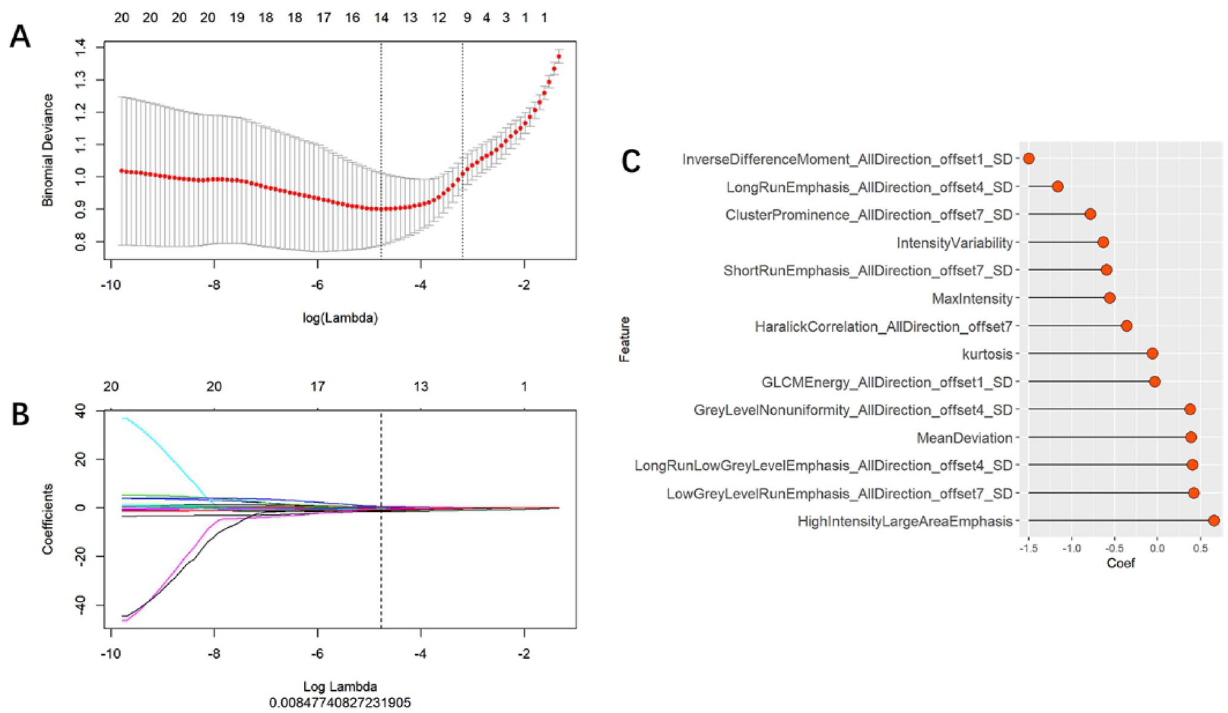
Figure 2. Feature selection using the LASSO-based logistic regression. ( A ) Selection of the tuning parameter (λ) using tenfold cross-validation and the minimum criteria. A plot of the partial likelihood deviance was made against log (λ). The minimum and 1-SE criteria were used to draw the dotted vertical lines at the optimal values. ( B ) Profiles of the LASSO coefficients for the 20 texture features. The vertical line was drawn at a value selected from the log (λ) sequence using tenfold cross-validation. Six features of non-zero coefficients are shown. ( C ) The selected radiomic features and corresponding